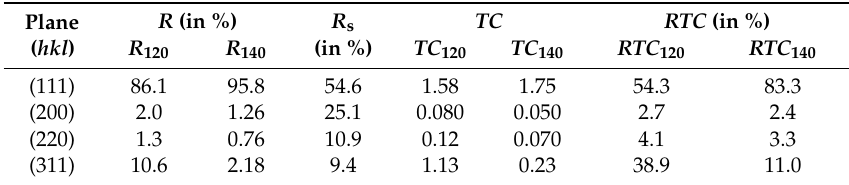
Table 4. Texture calculations for Cu coatings obtained by the PC regimes with a j A of 120 and 140 mA · cm − 2 ; s—Cu standard.